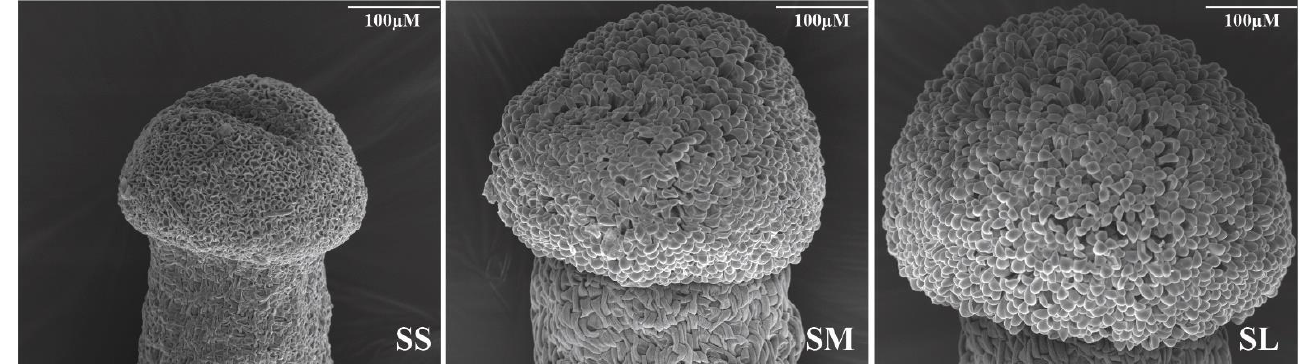
Figure 1. Morphological observation of different stages of stigma development. Stigma papilla cells were observed at different developmental stages using scanning electron microscope. Scale bars = 100 µM.